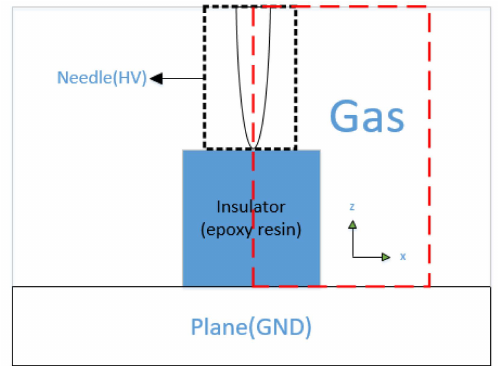
Figure 1. Structure of physical